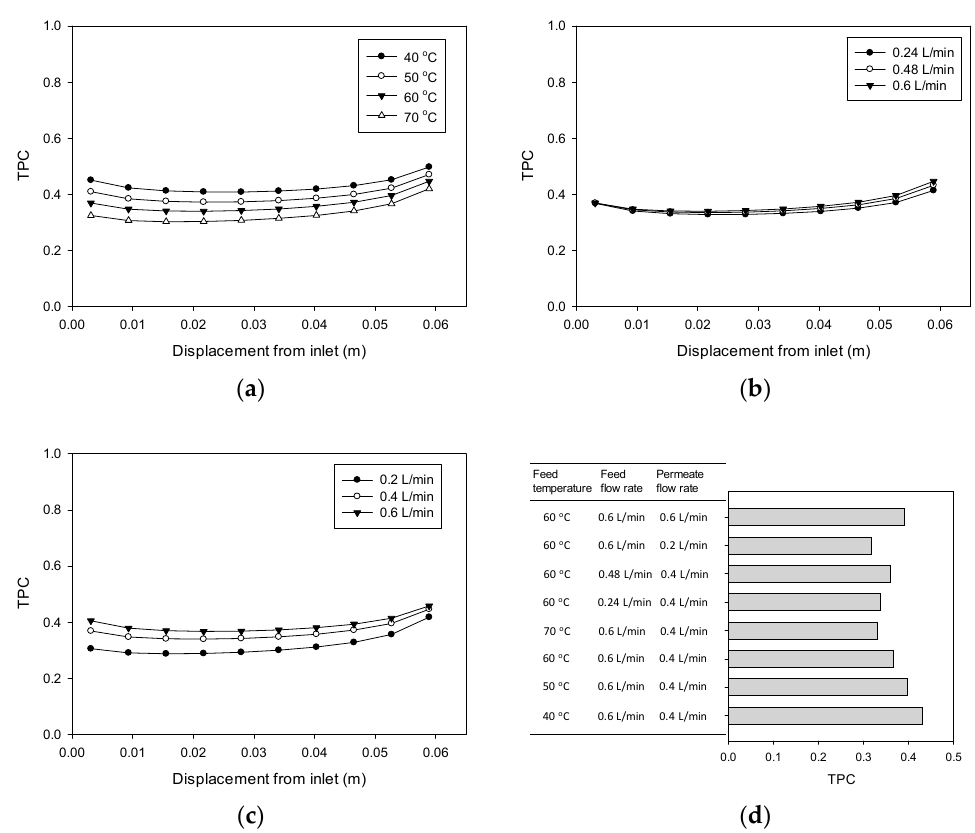
Figure 7. TP ratio inside the DCMD module: ( a ) effect of feed temperature, ( b ) effect of feed flow rate, ( c ) effect of permeate flow rate, and ( d ) comparison of average TP ratios under various conditions.